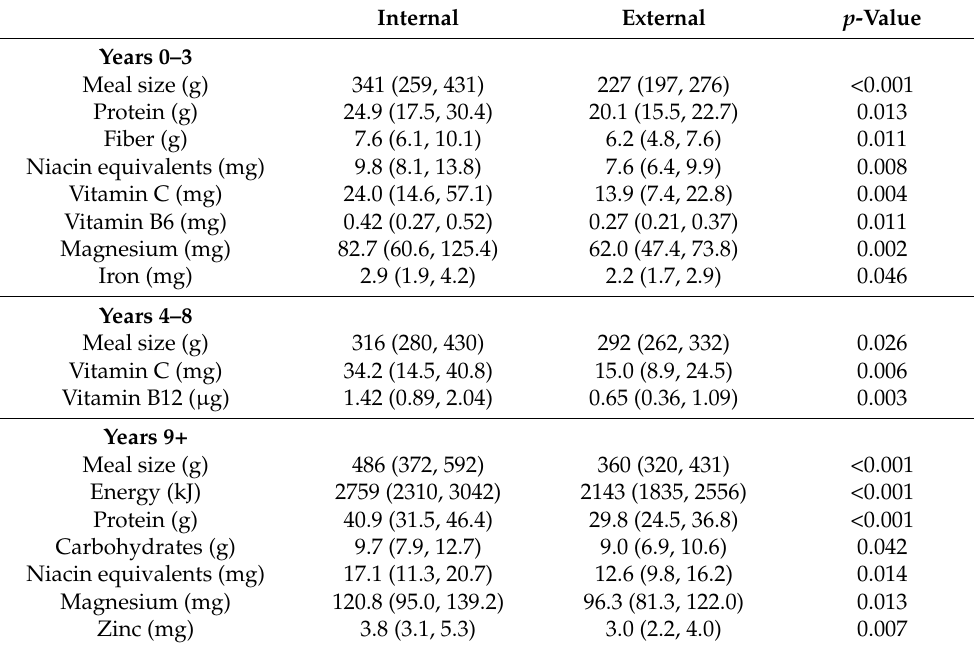
Table 5. Significant differences between meals from internal-provision schools and external